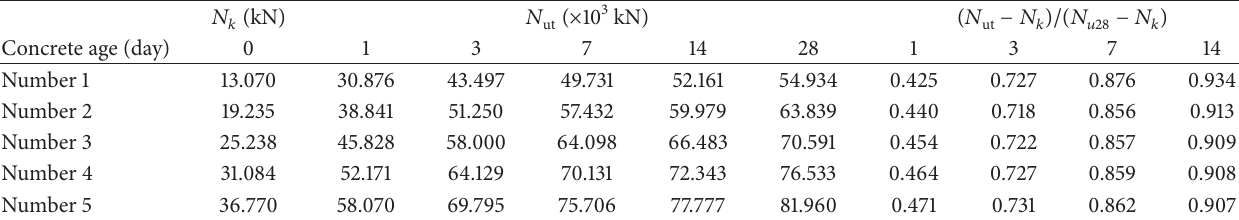
Table 5: Ultimate load-bearing capacity of the axially compressed columns.